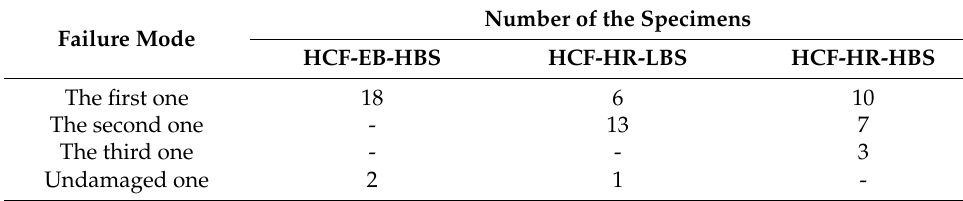
Number of the Specimens